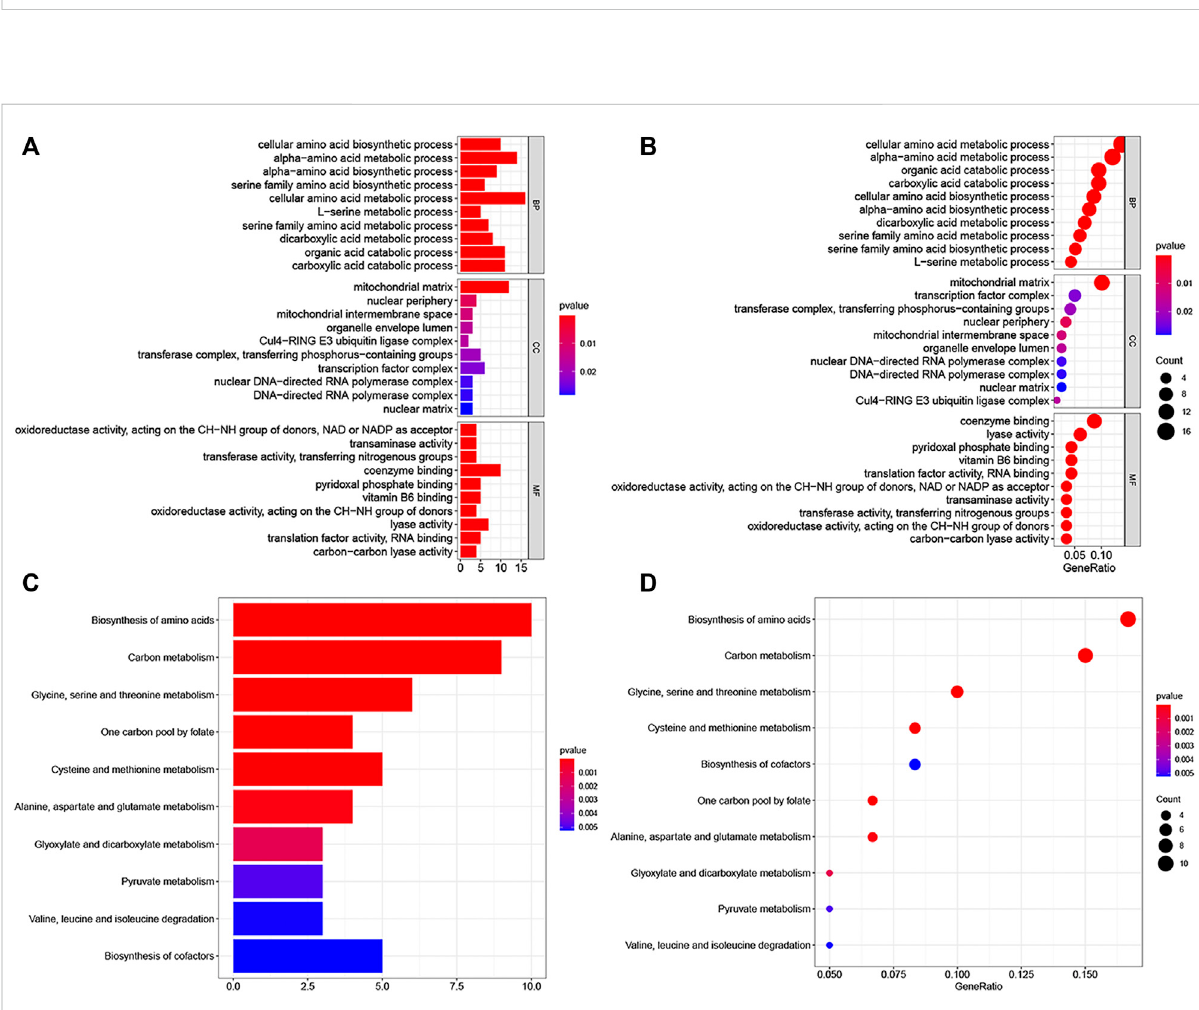
FIGURE 7 GO terms and the KEGG pathway. (A) Histogram presentation of GO enrichment of LINC00662-related genes in biological processes (BP), cellular components (CC) and molecular functions (MF) of top 10 terms; (B) Bubble chart of GO enrichment of LINC00662-related genes in the aspects of BP, CC, MF of top 10 terms; (C) Histogram presentation of top 10 signi fi cant pathways related to the LINC00662-related genes by the KEGG pathway analysis; (D) Bubble chart of top 10 signi fi cant